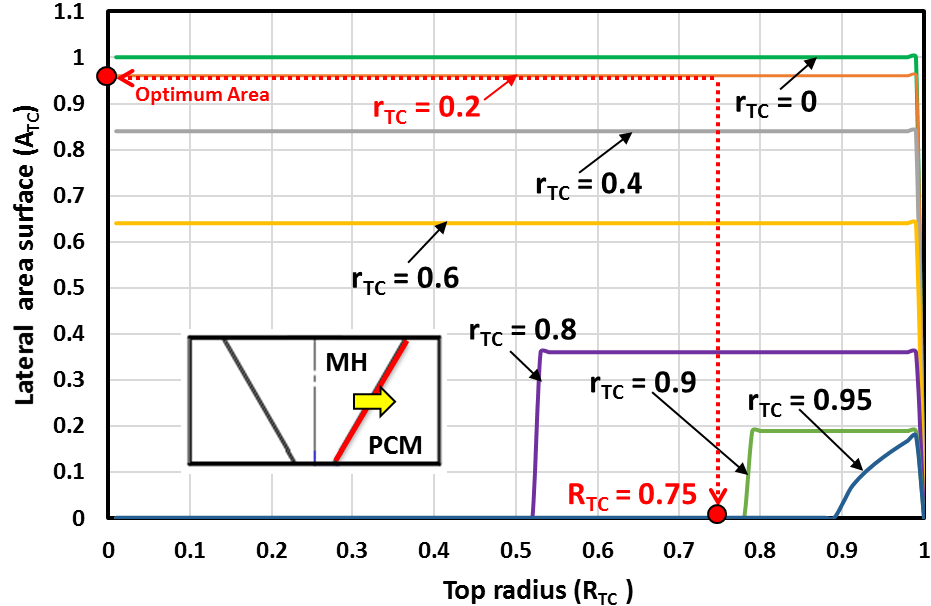
Figure 5. The lateral surface area for different top and bottom radii.